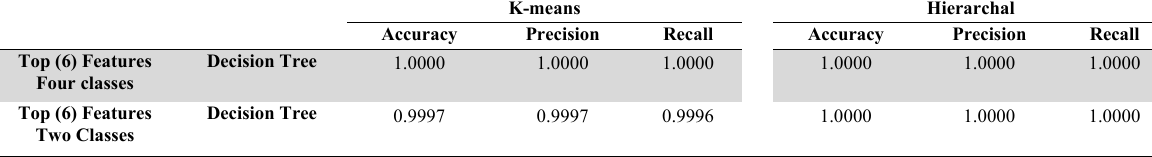
Classification results after the clustering process with the top six features K-means Hierarchal Accuracy Precision Recall Accuracy Precision